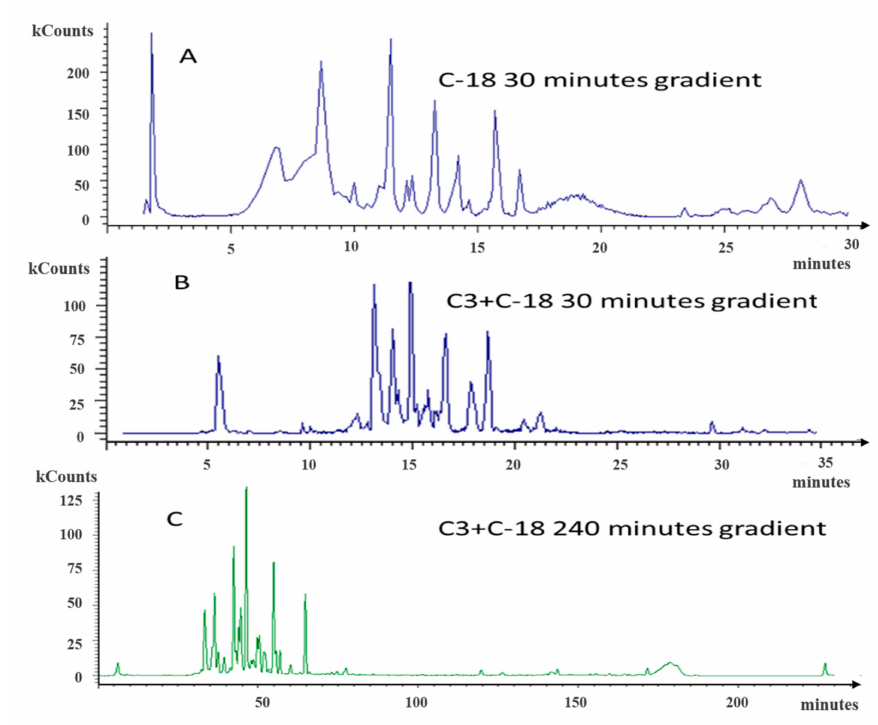
Figure 2. B. retusa bark LC-MS chromatogram peaks. Figures represent the spectra of the three di ff erent gradients employed, C-18 30 minutes’ gradient ( A ), C3 + C-18 30 minutes’ gradient ( B ), C3 + C-18 240 min gradient ( C ).